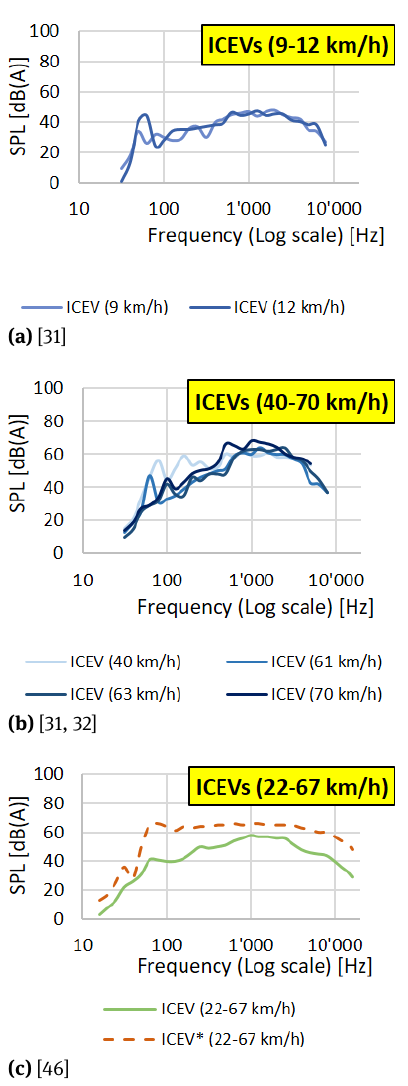
Figure 3: A-weighted Sound Pressure Level (Statistical Pass-By method, ISO 11819-1:1997) of ICEVs at different speeds (* = heavy vehicle) [31, 32, 45].